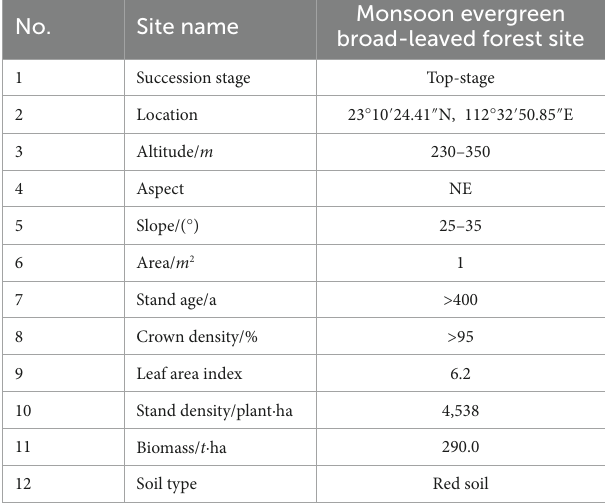
TABLE 1 Description of the permanent